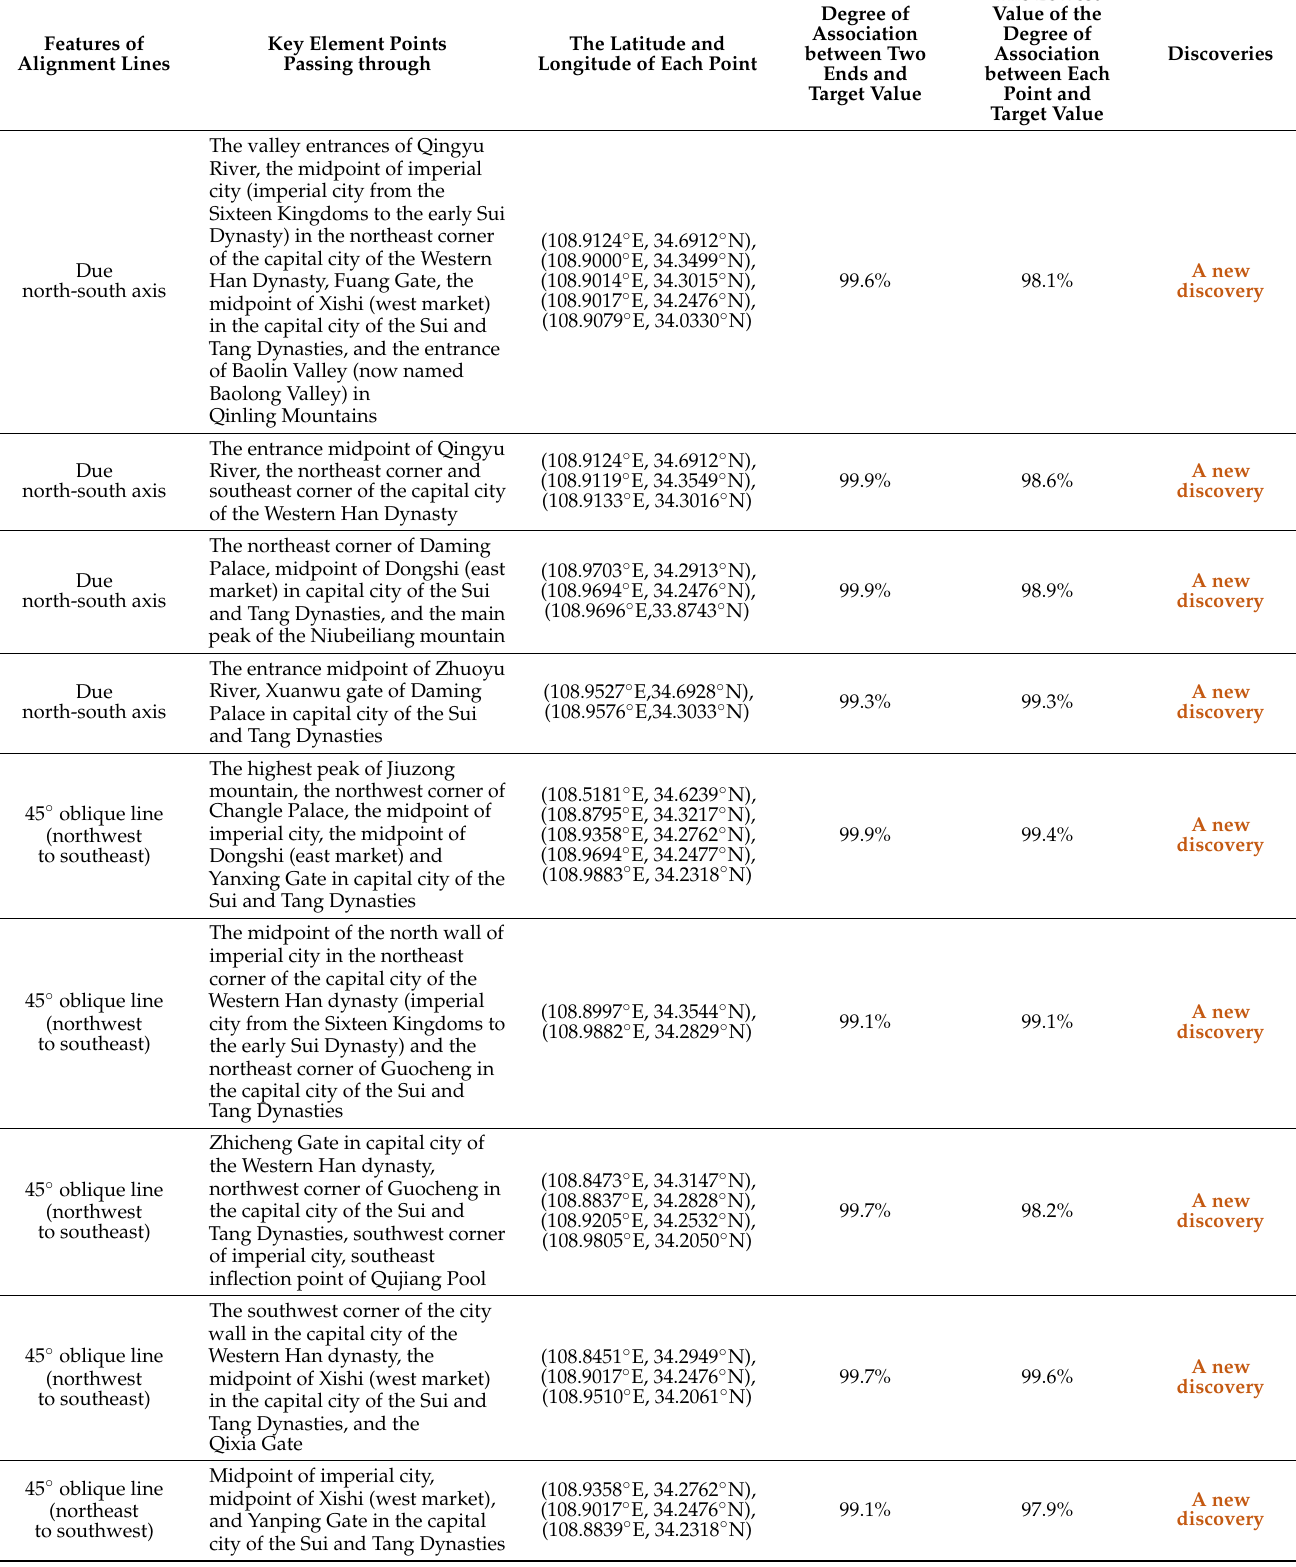
Table 4. List of the analysis results of the spatial relationship between Chinese capitals of the Western Han dynasty as well as the Sui and Tang dynasties and the natural environment (new